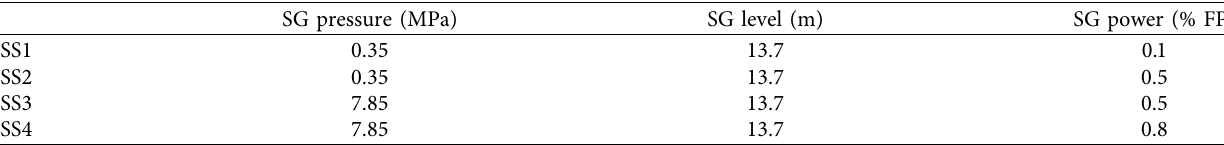
Figure 2: Flowchart of the ESPRIT facility. SG: steam generator; SV: safety valve; FEV: Venturi flowmeter; HT: heater; EMT: emergency make-up tank; ST: safety tank; EX: heat exchanger; LV: manual valve; MV: motor valve. Table 1: The initial conditions of four steady-state tests.